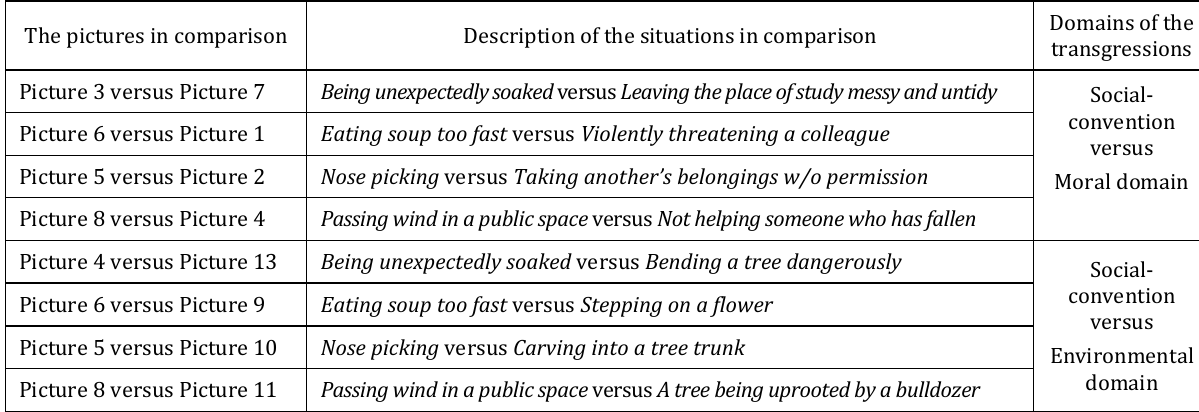
Table 3. Description of the pairs of images used in the Environmental Judgement